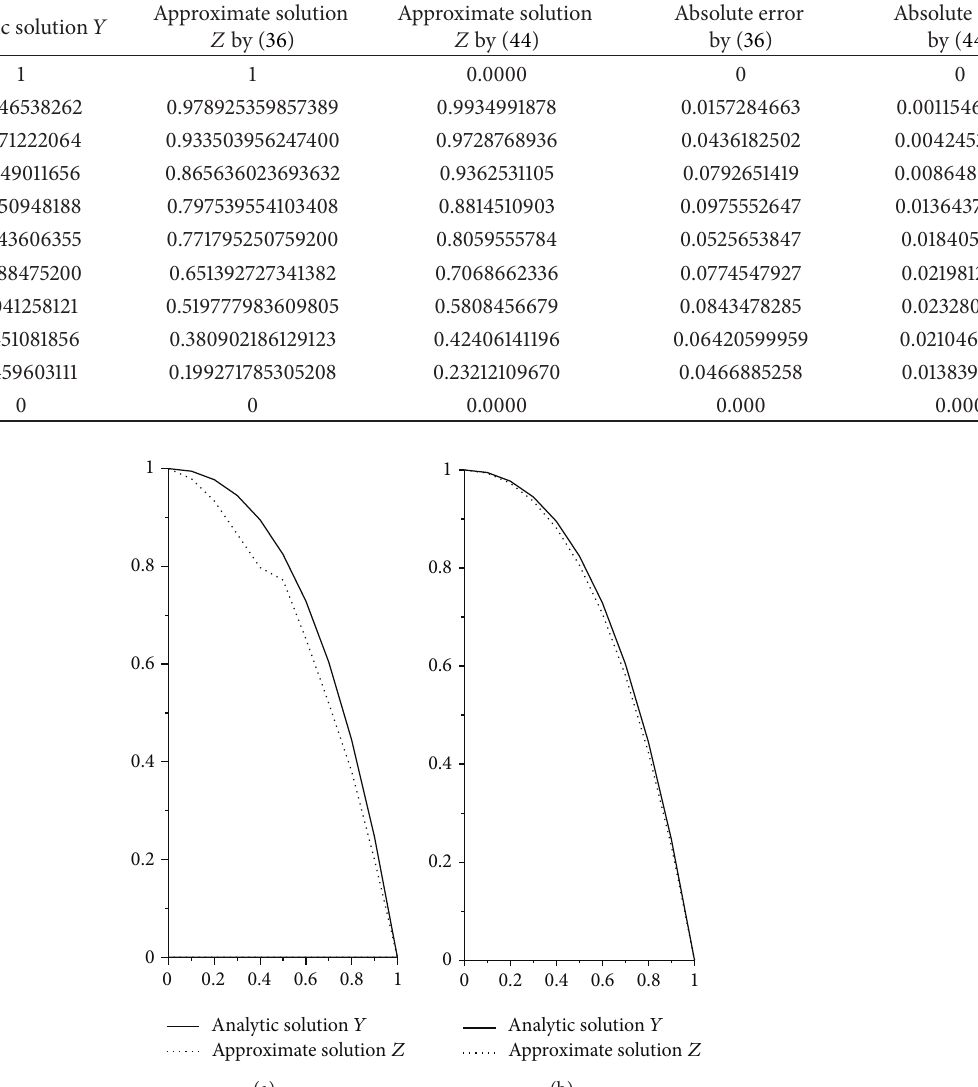
Table 2: Solutions and error estimation of Example 1.